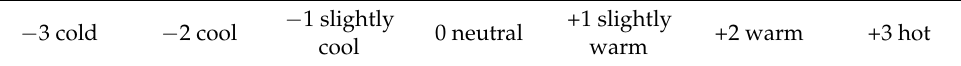
Table 5. Predicted mean vote (PMV) index values and the corresponding thermal comfort